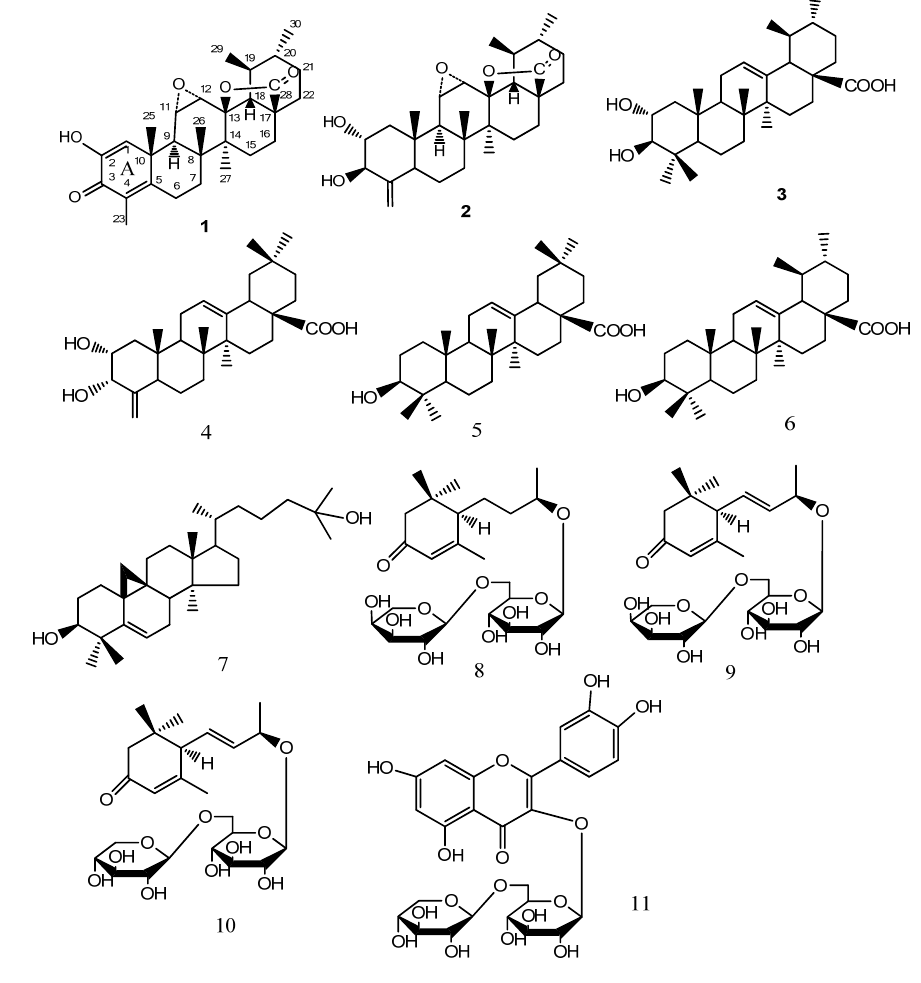
Figure 1. Structures of compounds 1 – 11